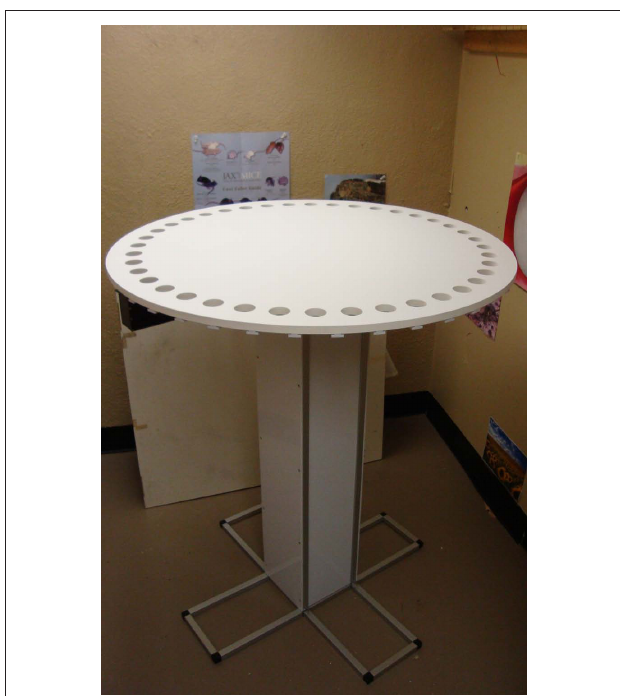
Figure 2 | The Barnes maze is a test of spatial memory. The apparatus is a large circular platform with holes spaced evenly around the periphery. The animal is placed in the middle of the platform and is motivated to escape the flat, open surface (necessity of escape is accentuated by bright flood lights shined on the platform). Using spatial cues placed around the platform, the animal learns the location of the single hole, which contains a darkened